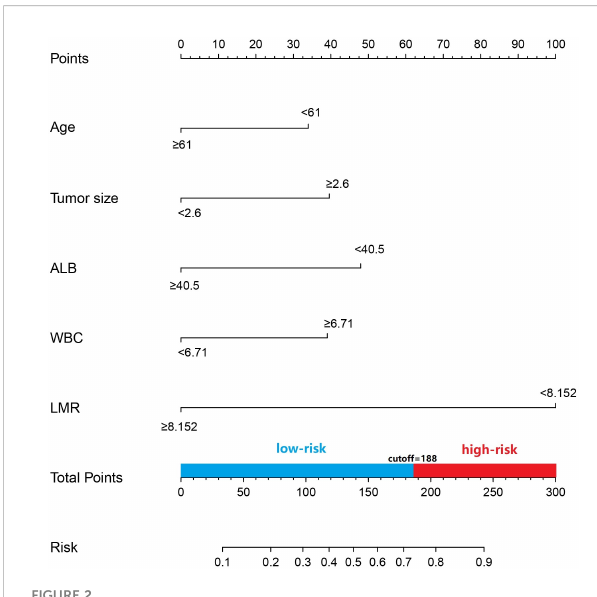
FIGURE 2 Prediction of LNM in patients with pancreatic head cncer using a nomogram. To get the position of each factor on the corresponding axis, draw lines on the point axis to represent the number of points. Add all the scores and fi nd the place of the total score to determine the probability of LNM for that line in the nomogram.